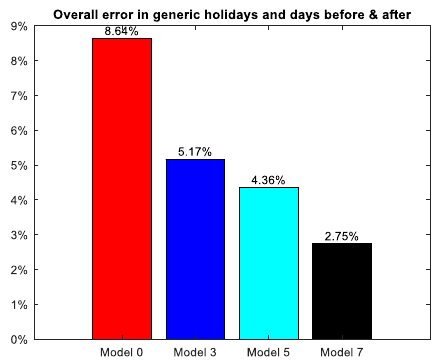
Figure 11. MAPE for models 0, 3, 5 and 7 for generic holidays and days before or after a holiday.